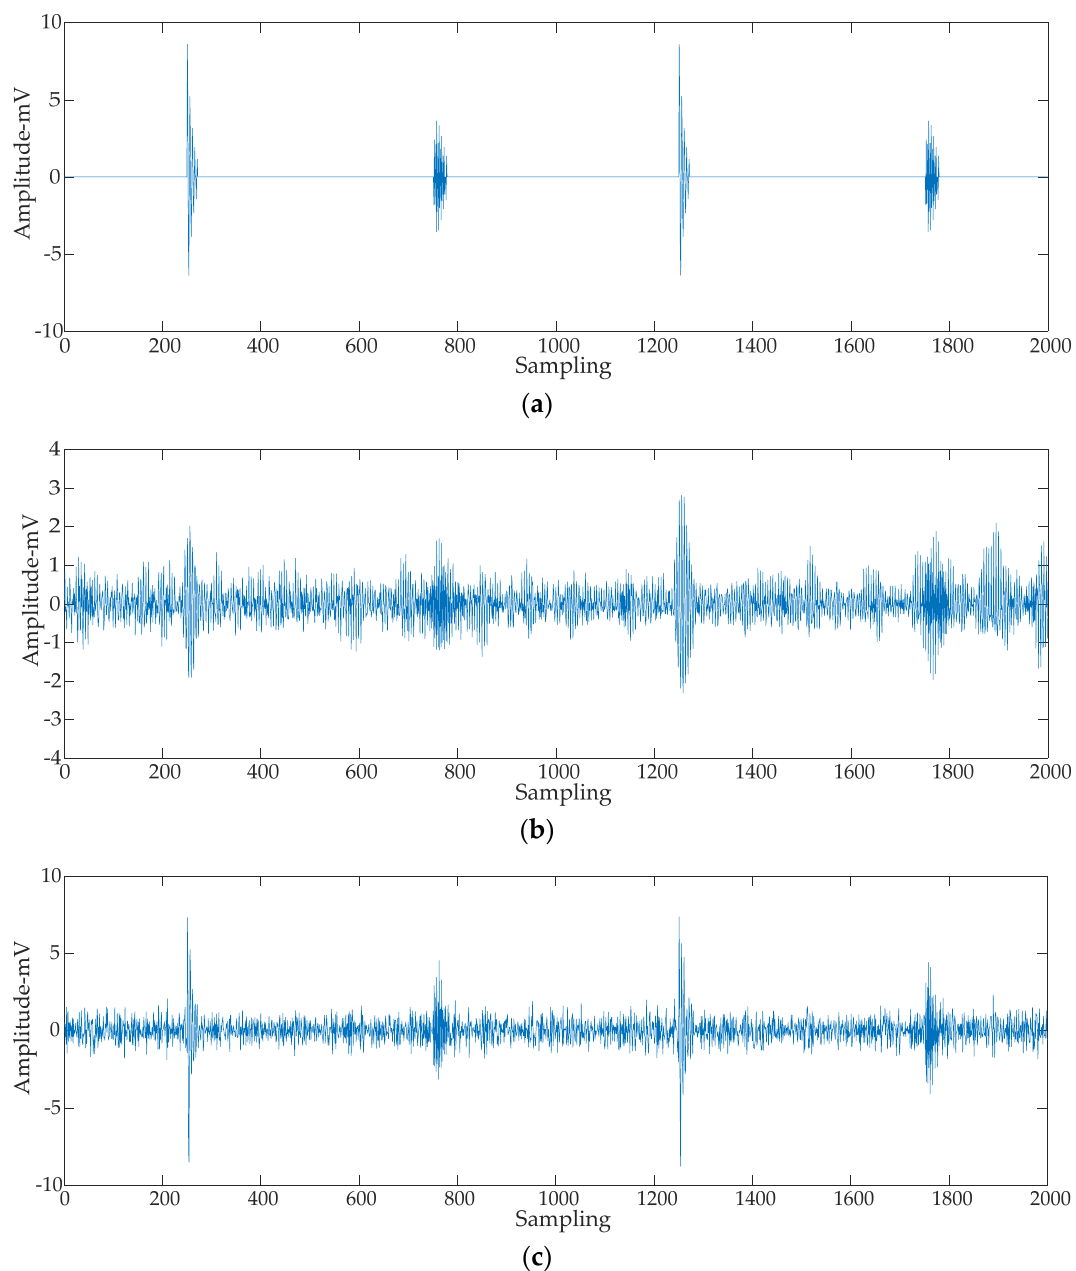
Figure 14. Results of interference suppression methods. ( a ) Interference suppression results of the proposed method. ( b ) Interference suppression results of SVD. ( c ) Interference suppression results of SVD + EMD.